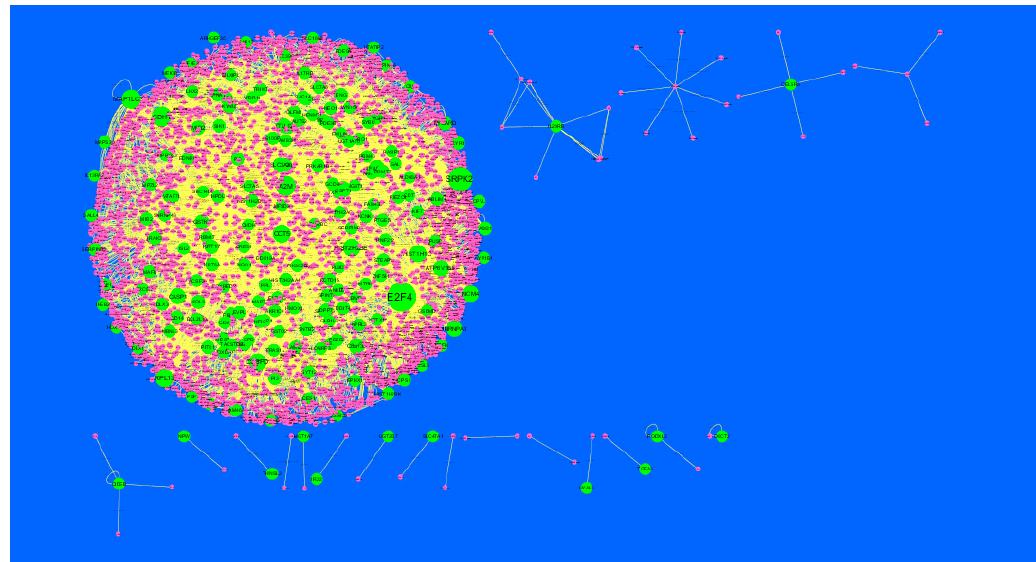
Figure 5. Protein-protein interaction (PPI) networks for differentially-expressed genes (DEGs). (Dark green round shape node represents up-regulated genes). Pink dots are also genes which are not hub or differential expressed genes. White rod shape is interaction with adjutant genes.